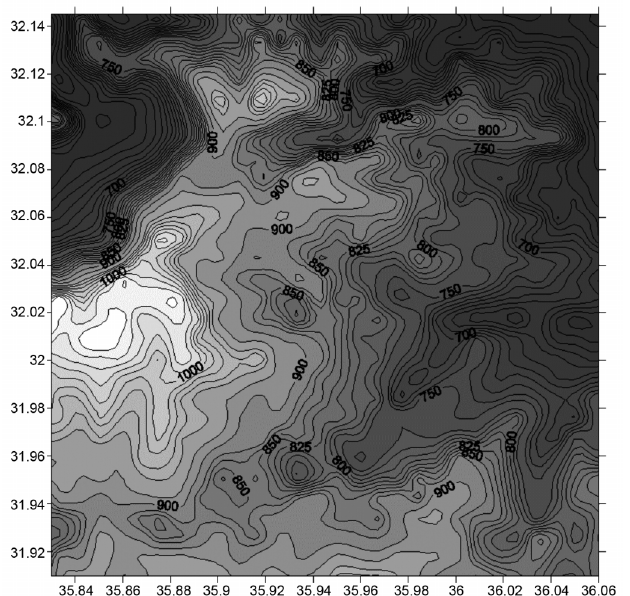
Fig. 8. The DTM extracted from the topographic map in tested area (latitude and longitude in WGS84 and con- tours value in